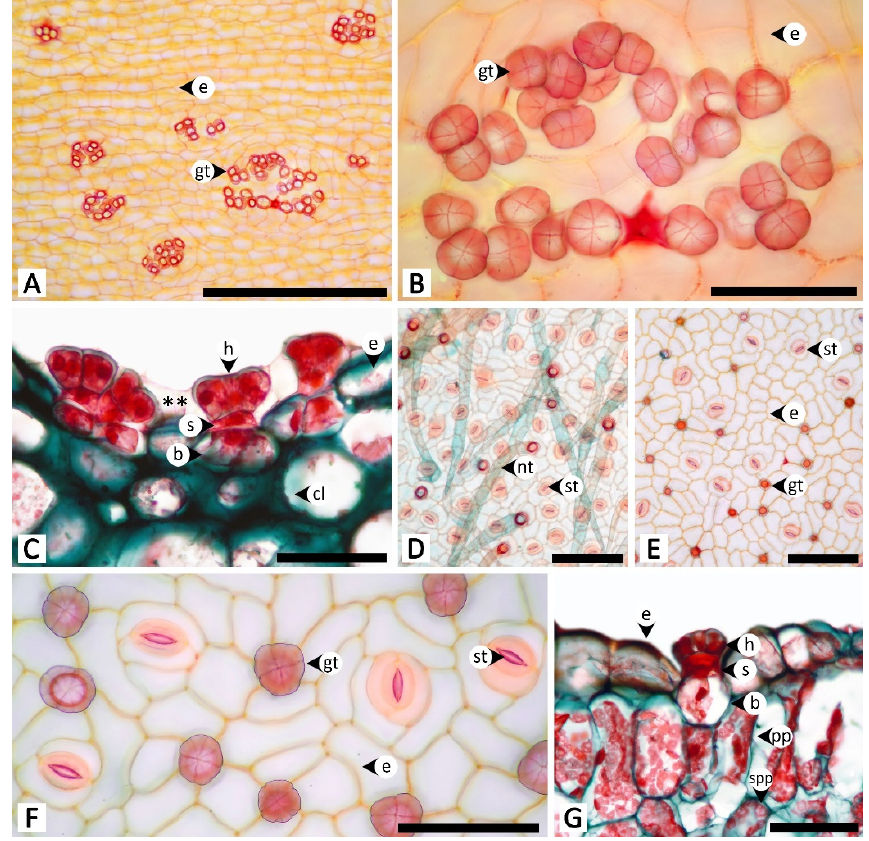
Figure 4. Micromorphology and anatomy of calycinal ( A – C ) and foliar ( D – G ) glands of Rivea ornata via light microscopy. ( A ) Adaxial surface of a sepal with clusters of calycinal glands. ( B ) Close-up view of ( A ) showing details of the multicellular head of the calycinal glands. ( C ) Transversal view of the adaxial side of a sepal showing a cluster of calycinal glands in the shallow pit with traces of exudate (double asterisk). ( D ) Abaxial leaf surface possessing only non-glandular trichomes. ( E ) Adaxial leaf surface possessing only glandular trichomes distributed solitarily on the epidermis. ( F ) Close-up view of ( E ) showing details of the multicellular head of the glandular trichomes. ( G ) Transversal view of a leaf showing details of the glandular trichomes. Abbreviations: b, base; cl, collenchyma; e, epidermal cell; f, filament; gt, glandular trichome; h, head; nt, non-glandular trichome; pp, palisade parenchyma; s, stalk; spp, spongy parenchyma; st, stoma. Scale bars: ( A ) 500 µ m; ( B , F ) 100 µ m; ( D , E ) 200 µ m; ( G ) 50 µ